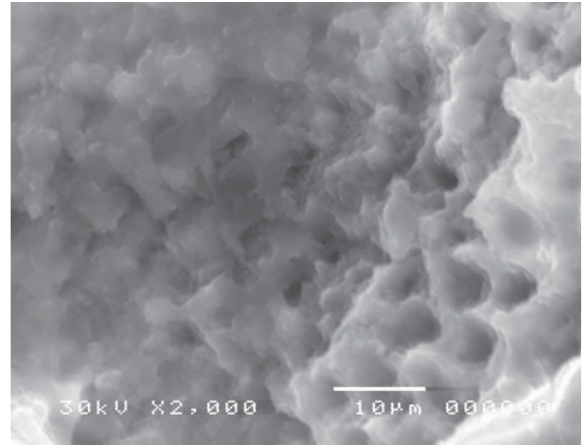
Figure 10- Electron-micrograph in gamma (GL) group subjected (cid:87)(cid:82)(cid:3)(cid:79)(cid:68)(cid:86)(cid:72)(cid:85)(cid:3)(cid:86)(cid:75)(cid:82)(cid:90)(cid:76)(cid:81)(cid:74)(cid:3)(cid:70)(cid:82)(cid:81)(cid:192)(cid:88)(cid:72)(cid:81)(cid:70)(cid:72)(cid:3)(cid:82)(cid:73)(cid:3)(cid:87)(cid:88)(cid:69)(cid:88)(cid:79)(cid:68)(cid:85)(cid:3)(cid:68)(cid:81)(cid:71)(cid:3)(cid:76)(cid:81)(cid:87)(cid:72)(cid:85)(cid:87)(cid:88)(cid:69)(cid:88)(cid:79)(cid:68)(cid:85)(cid:3)(cid:86)(cid:87)(cid:85)(cid:88)(cid:70)(cid:87)(cid:88)(cid:85)(cid:72)(cid:86)(cid:15)(cid:3) the intertubular dentine was ablated more than the peritubular dentine, giving the appearance of irregularity and protrusion of the dentinal tubules